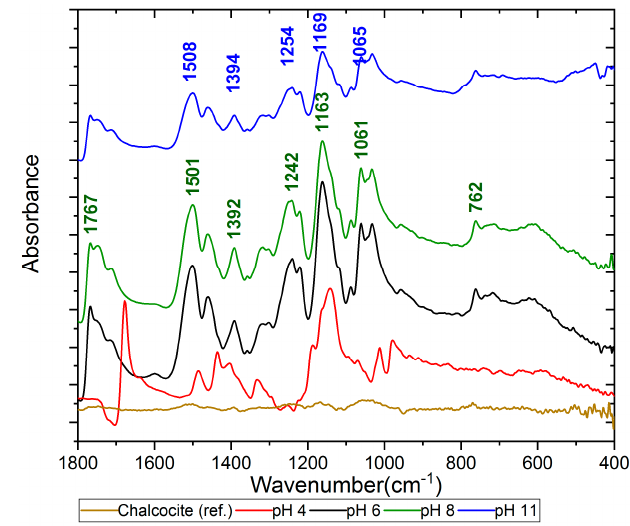
Figure 13. DRIFT spectra of thionocarbamate adsorption on chalcocite with increasing pH.